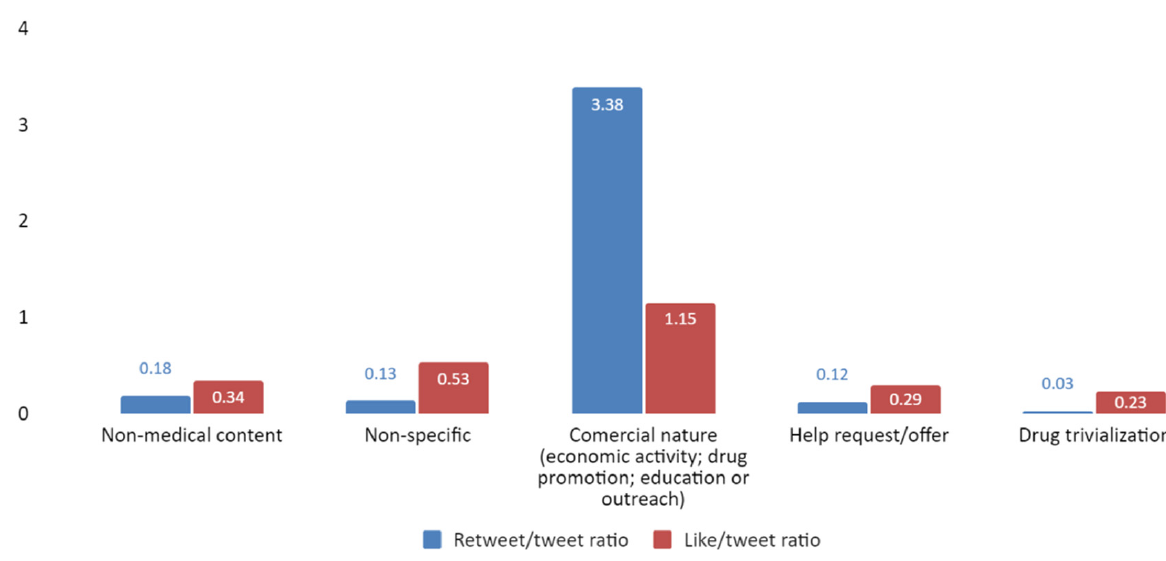
Figure 7. Retweet and like ratio ( Y -axis) by non-medical content category ( X -axis).